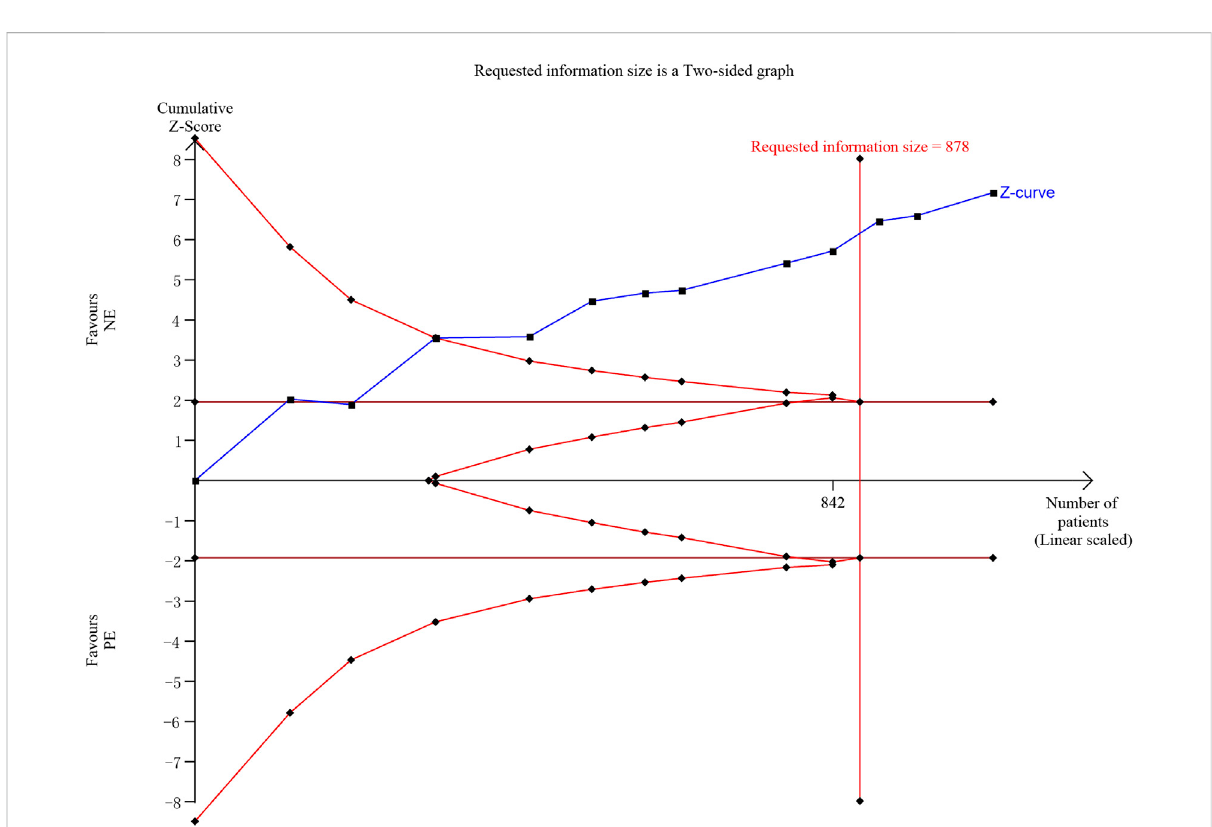
FIGURE 10 Trialsequential analysis oftheincidenceofbradycardia.Wecalculated aspending-adjusted required information size(RIS)usinga=0.05(two- sided), and power = 80%. Blue — the cumulative Z-curve; Deep red — the conventional boundary; red — the TSA